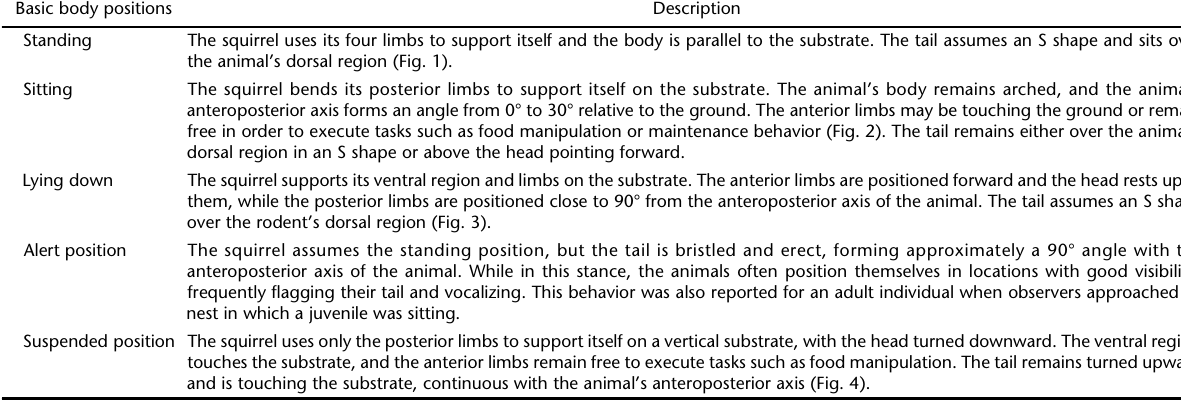
Table I. Description of the basic body positions used by Guerlinguetus